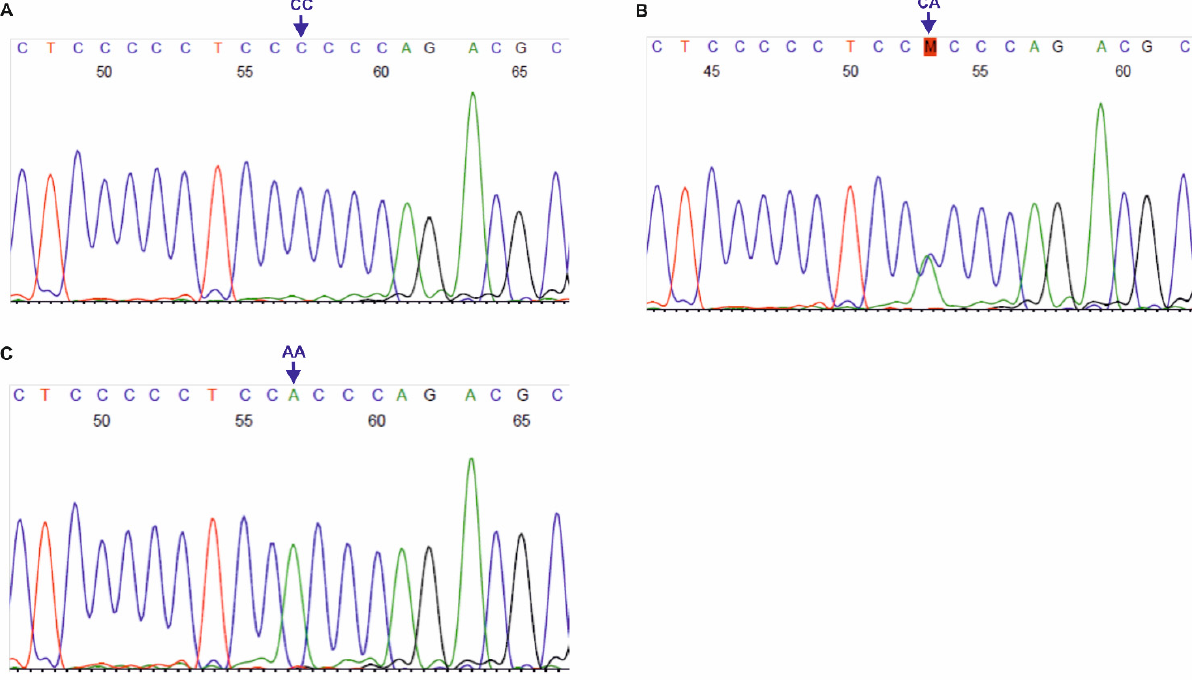
Figure 3. Chromatograms of DNA forward strands for DLX3 rs10459948 polymorphism ( A – C ). AA, CA, CC: genotypes in the tested